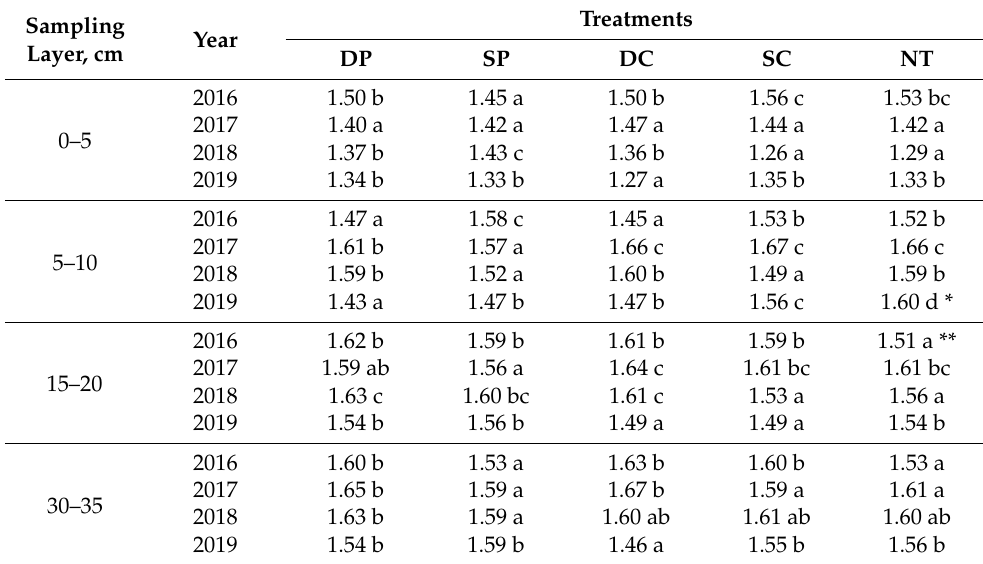
Table 2. Effect of tillage on soil bulk density (10 6 g m − 3 ) at different sampling depths, 2016–2019.